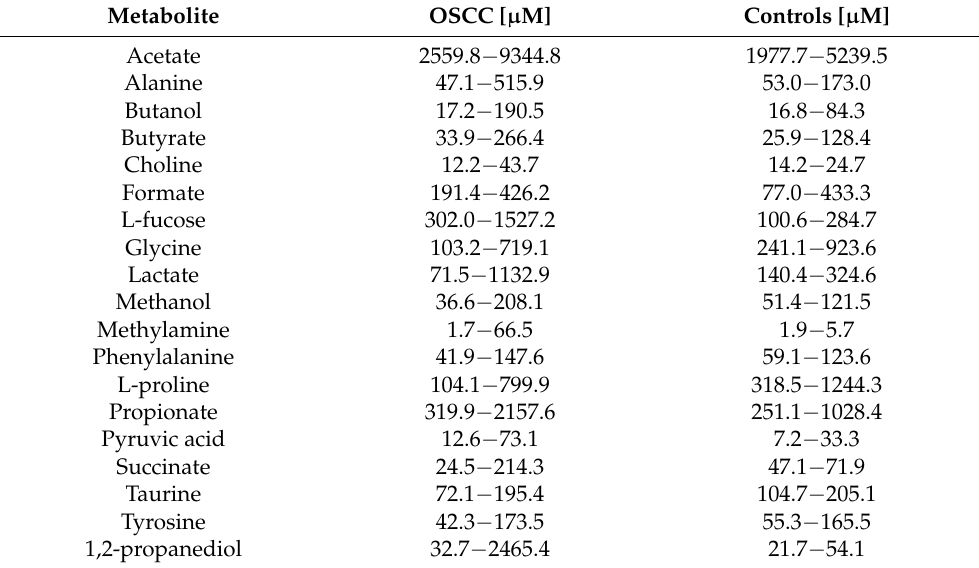
Table 2. Concentrations of salivary metabolites of oral squamous cell cancer (OSCC) (n = 8) patients and their healthy controls (n = 30) identified in an NMR study by Mikkonen et al.